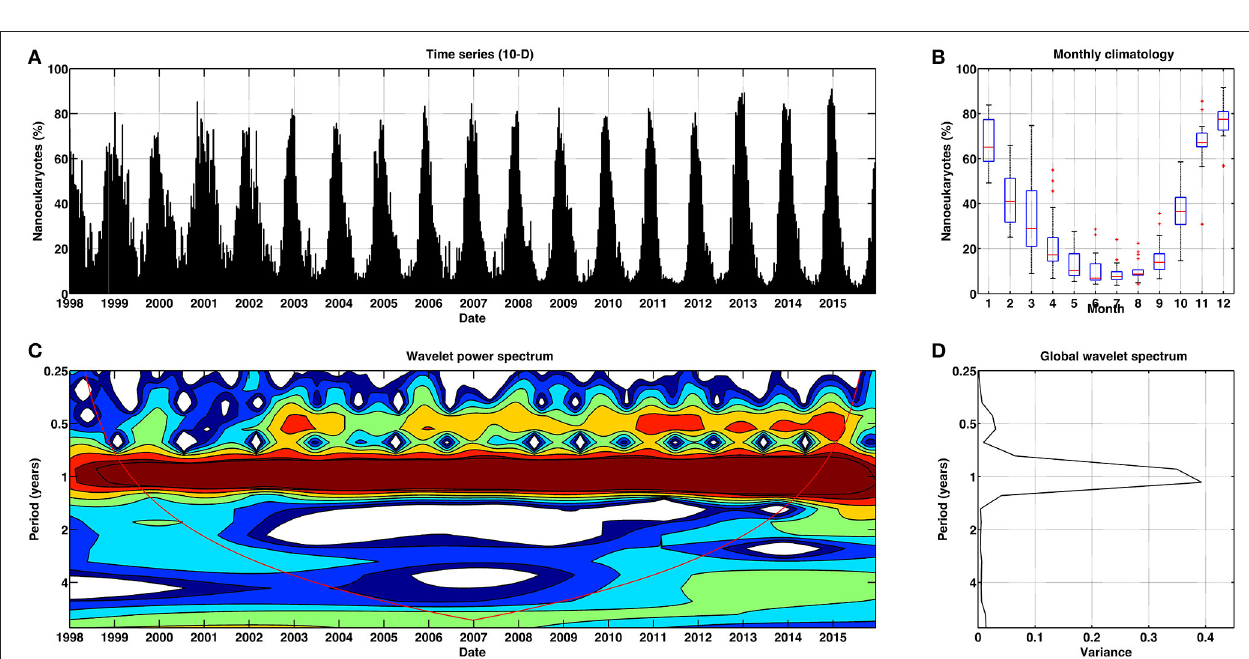
FIGURE 5 | Monthly climatology of the dominant phytoplankton groups detected by PHYSAT-Med OC-CCI during the study period (January 1998–December 2015).